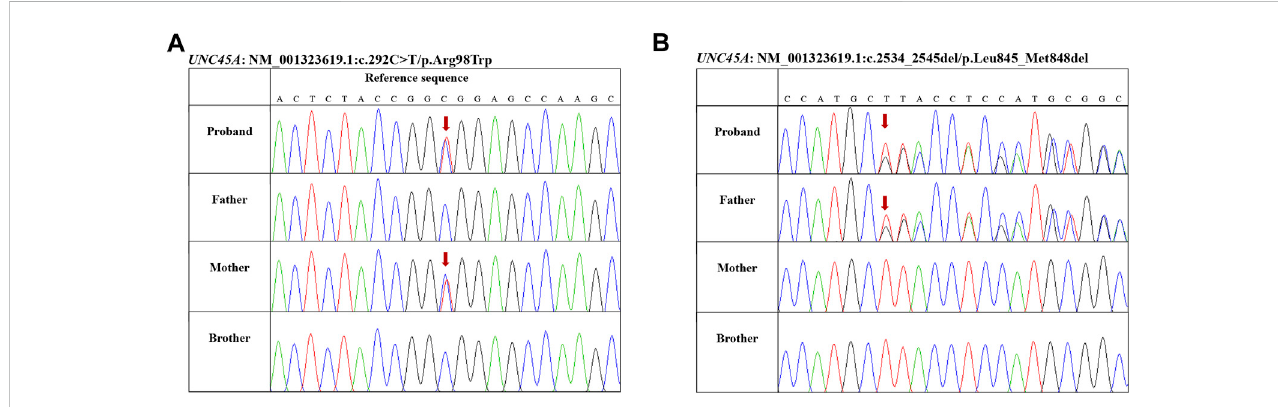
FIGURE 1 GenotypingofthefamilymembersbySangersequencing. (A) Probandandhismothercarryingvariantc.292C > T(p.Arg98Trp). (B) Probandandhisfather carrying variant c.2534-2545del